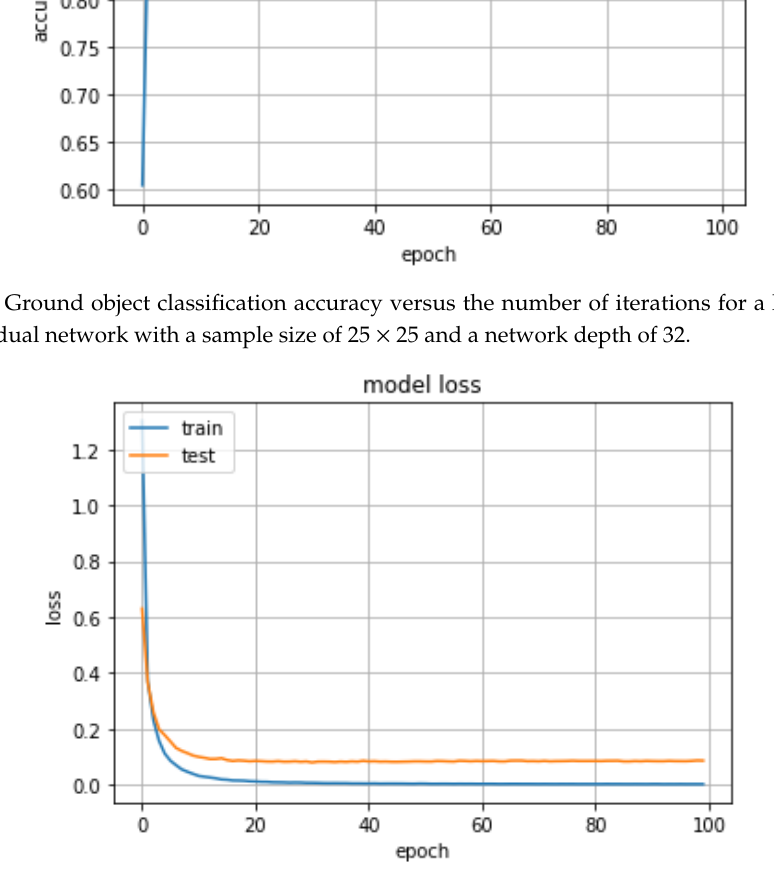
Figure 12. Ground object classification loss versus the number of iterations for a hierarchical fusion residual network with a sample size of 25 × 25 and a network depth of 32.